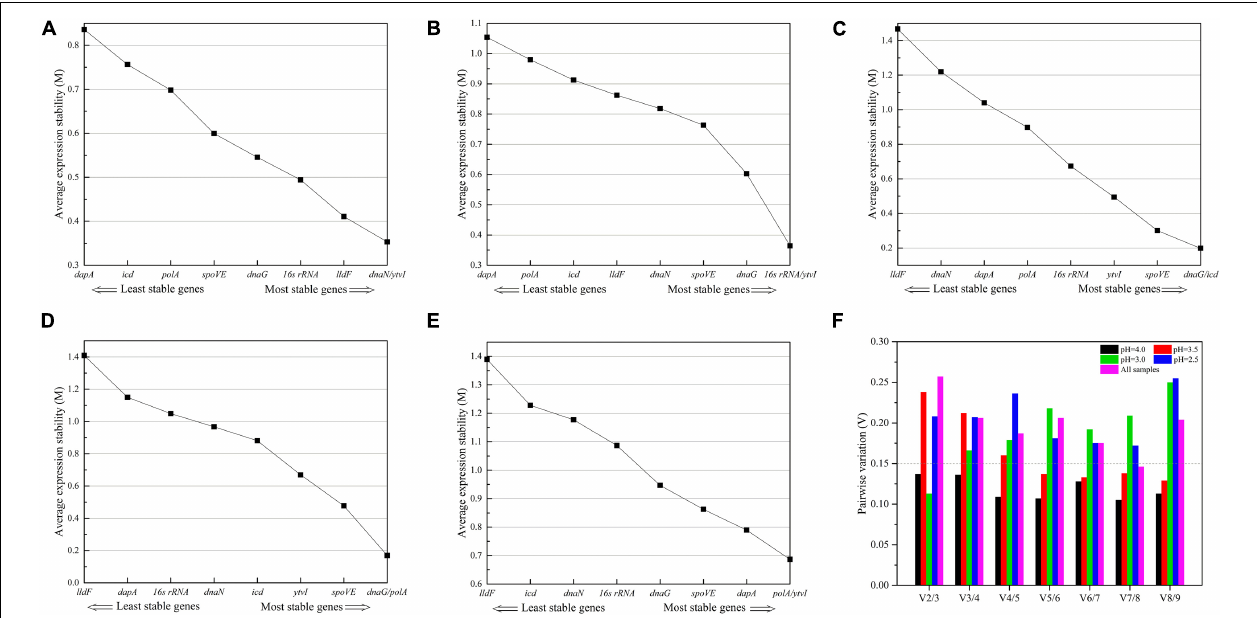
FIGURE 5 | Average expression stability (A–E) and optimal number of reference genes (F) calculated using geNorm program. (A–D) A. acidoterrestris cells treated at pH 4.0, 3.5, 3.0, and 2.5, respectively. (E) All samples. (F) The optimal number of reference genes was calculated based on the pairwise variation ( V n / V n + 1 ) values.